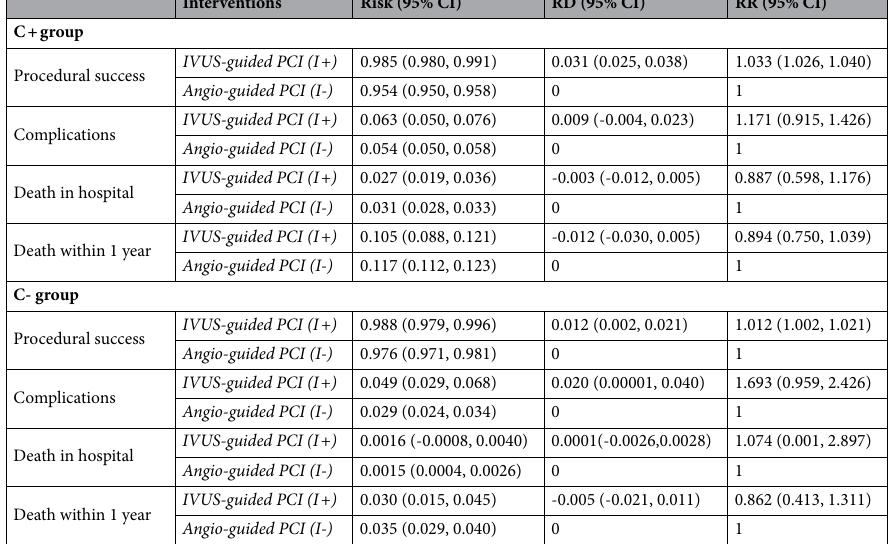
Table 4. Estimations of relative effects of IVUS-guided uses stratify by meet/unmeet IVUS criteria: A propensity score model by inverse-probability-weighted with regression adjustment. Abbreviations: C + , met criteria; C−, unmet criteria; CI, confidence interval; IVUS, intravascular ultrasound; I + , IVUS-guided PCI, I-, angio-guided PCI; PCI, percutaneous coronary intervention; RD, risk difference; RR, relative risk.